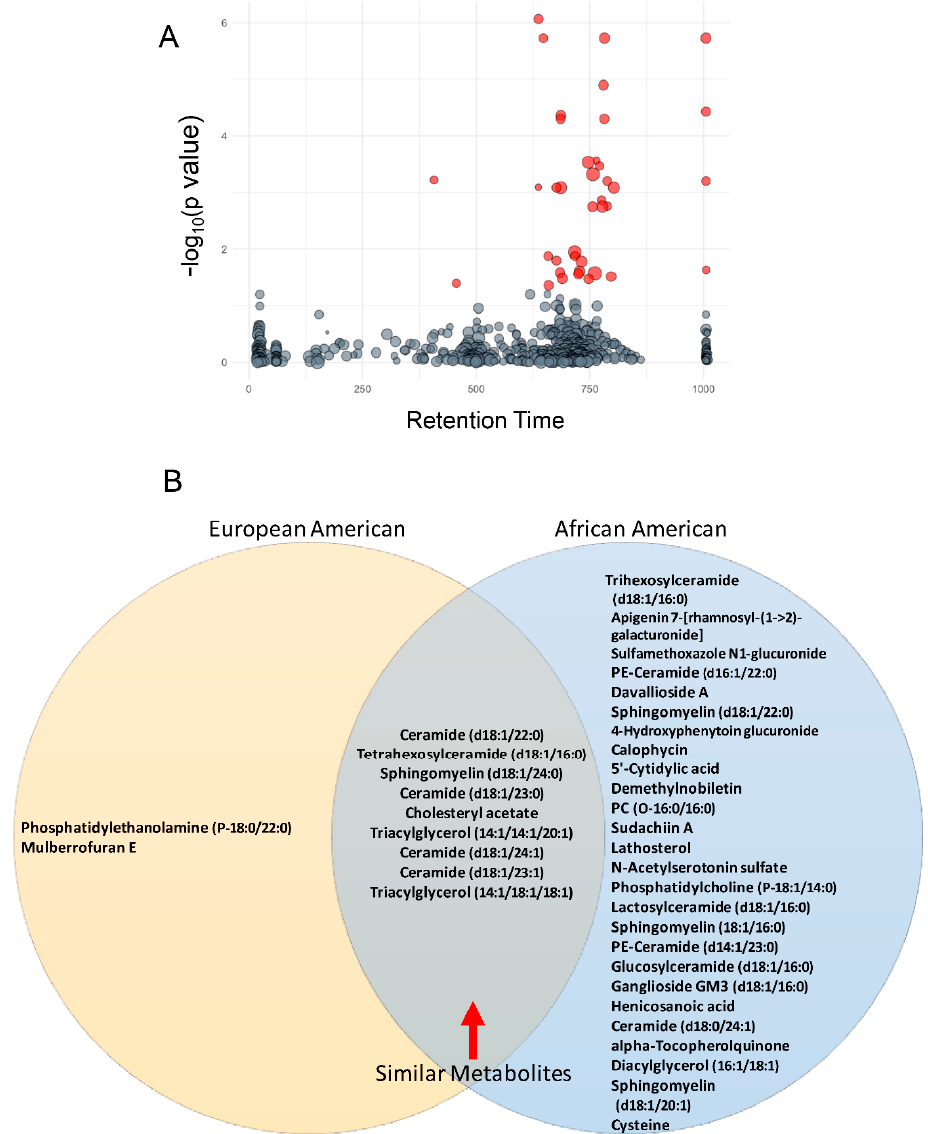
Figure 2. Plasma lipid association with aggressiveness in PCaP. ( A ) Metabolomic analysis revealed 35 plasma lipids were associated significantly with aggressiveness after FDR correction (red bubbles). Y axis displays ANOVA result (-log( p -value)). Bubble size is proportional to the log of the spectral signal intensity. ( B ) European-American and African-American men in this cohort shared nine common lipids, which included six sphingolipids that were associated with PCa aggressiveness. (*four chemical formulas were identified for which no chemical compound could be identified).